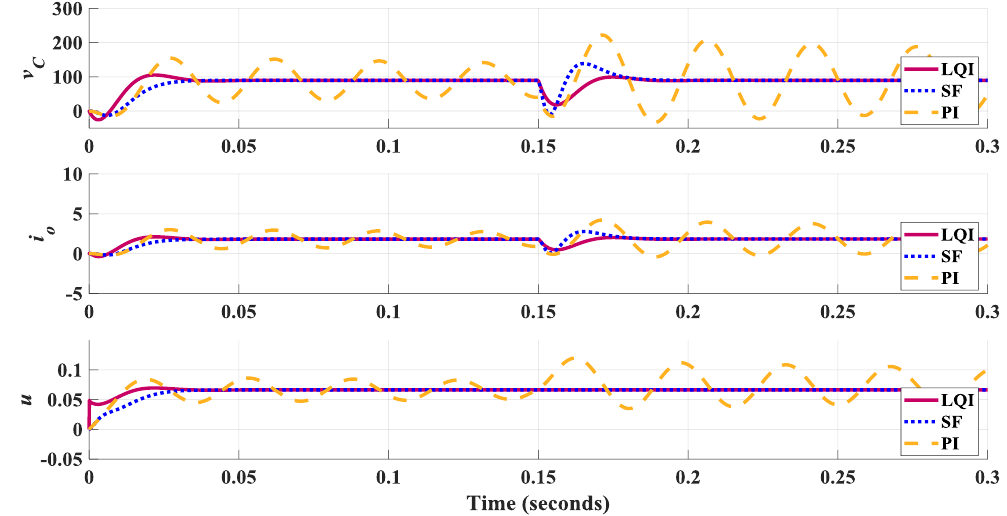
Figure 8. Simulation results for a load disturbance of 4 A under perturbed condition ( D = 0.45 and R o =